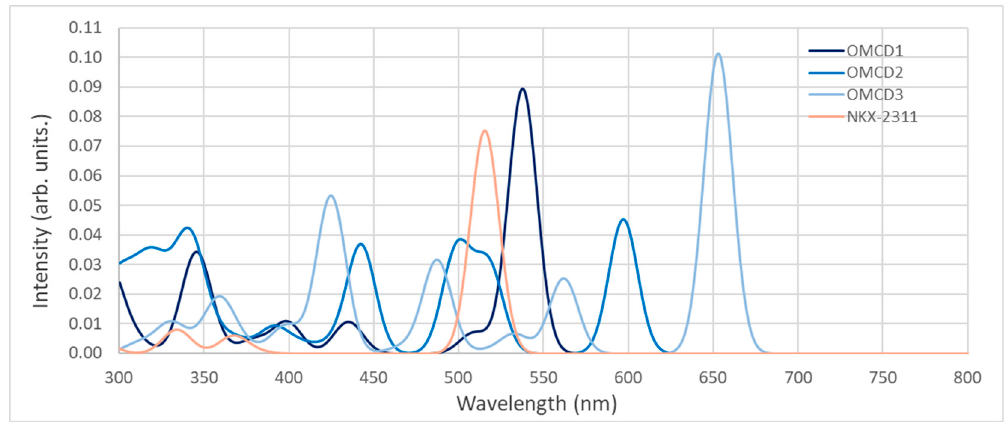
Figure 5. Theoretical UV-Vis spectra by TD-DFT calculation at B3LYP / DZVP level for the dyes in ethanol. The spectral lines were convoluted with Gaussian distributions of 20 nm linewidth at half maximum. Table 3. Spectral matching coefficient, between the calculated spectra of the dyes and the standard global total spectral irradiance AM1.5 G [88], based on Equation (8), for the isolated dye and the dye adsorbed on the TiO 2 nanocluster, for wavelengths between 300 and 900 nm.